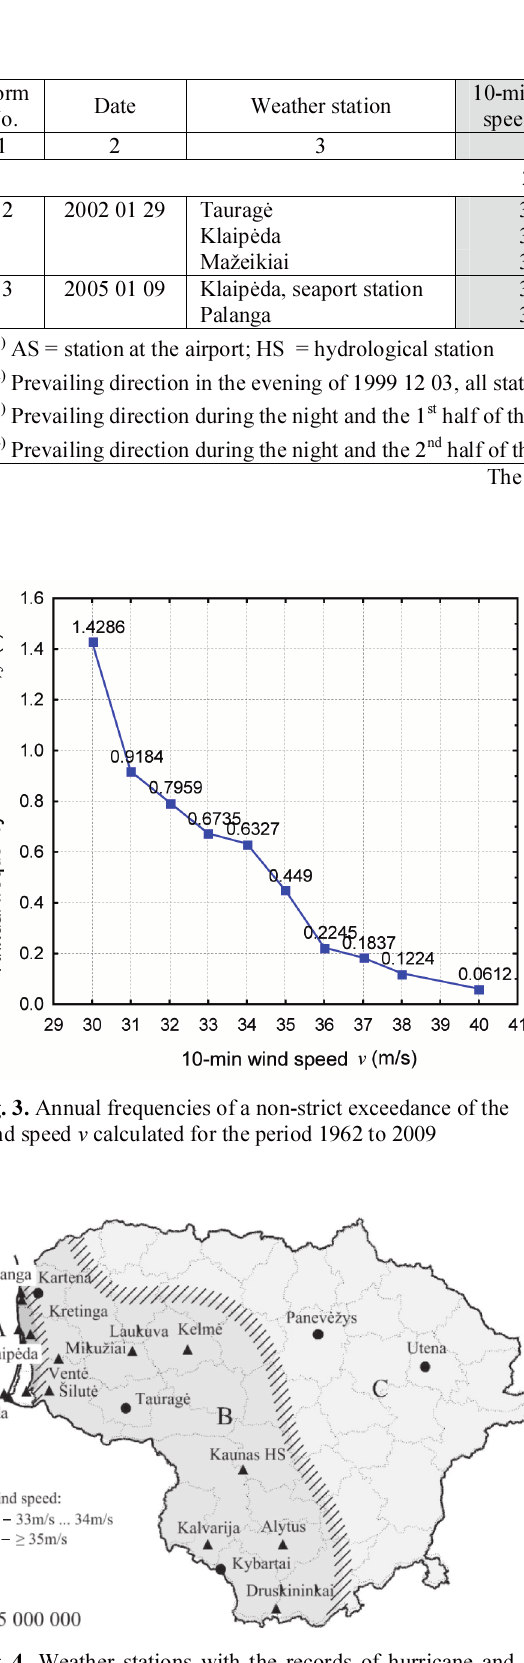
Fig. 4. Weather stations with the records of hurricane and ca- tastrophic winds as well as proposed hurricane wind regions A, B, and